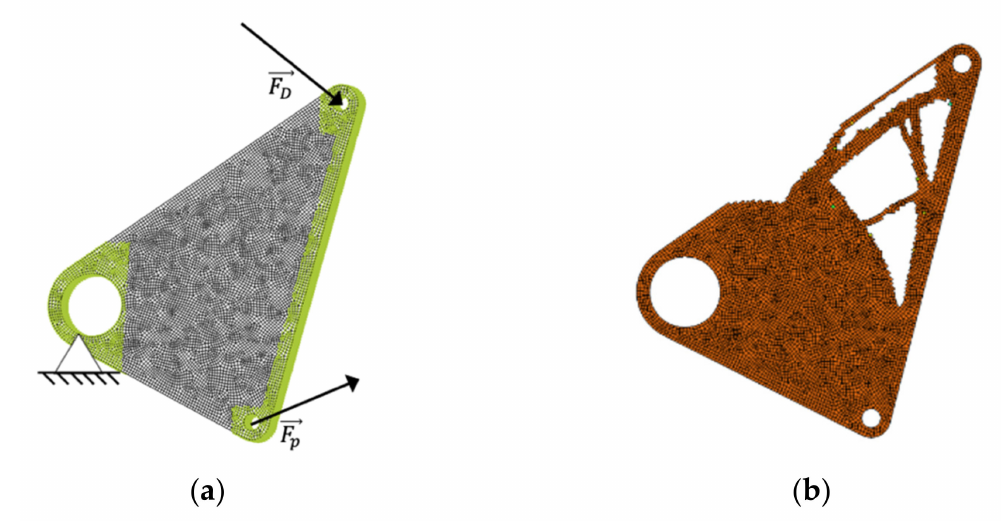
Figure 11. Tested configurations of the rocker: ( a ) TO setup, the green areas are non-design spaces; and ( b ) TO result without the consideration of the manufacturing conflicts.